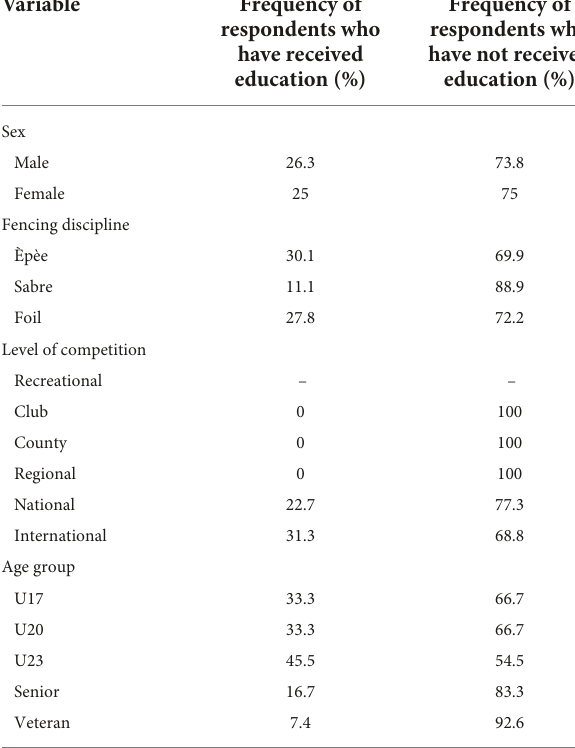
TABLE 4 A comparison between participant variables and the obtaining of education on caffeine supplementation.